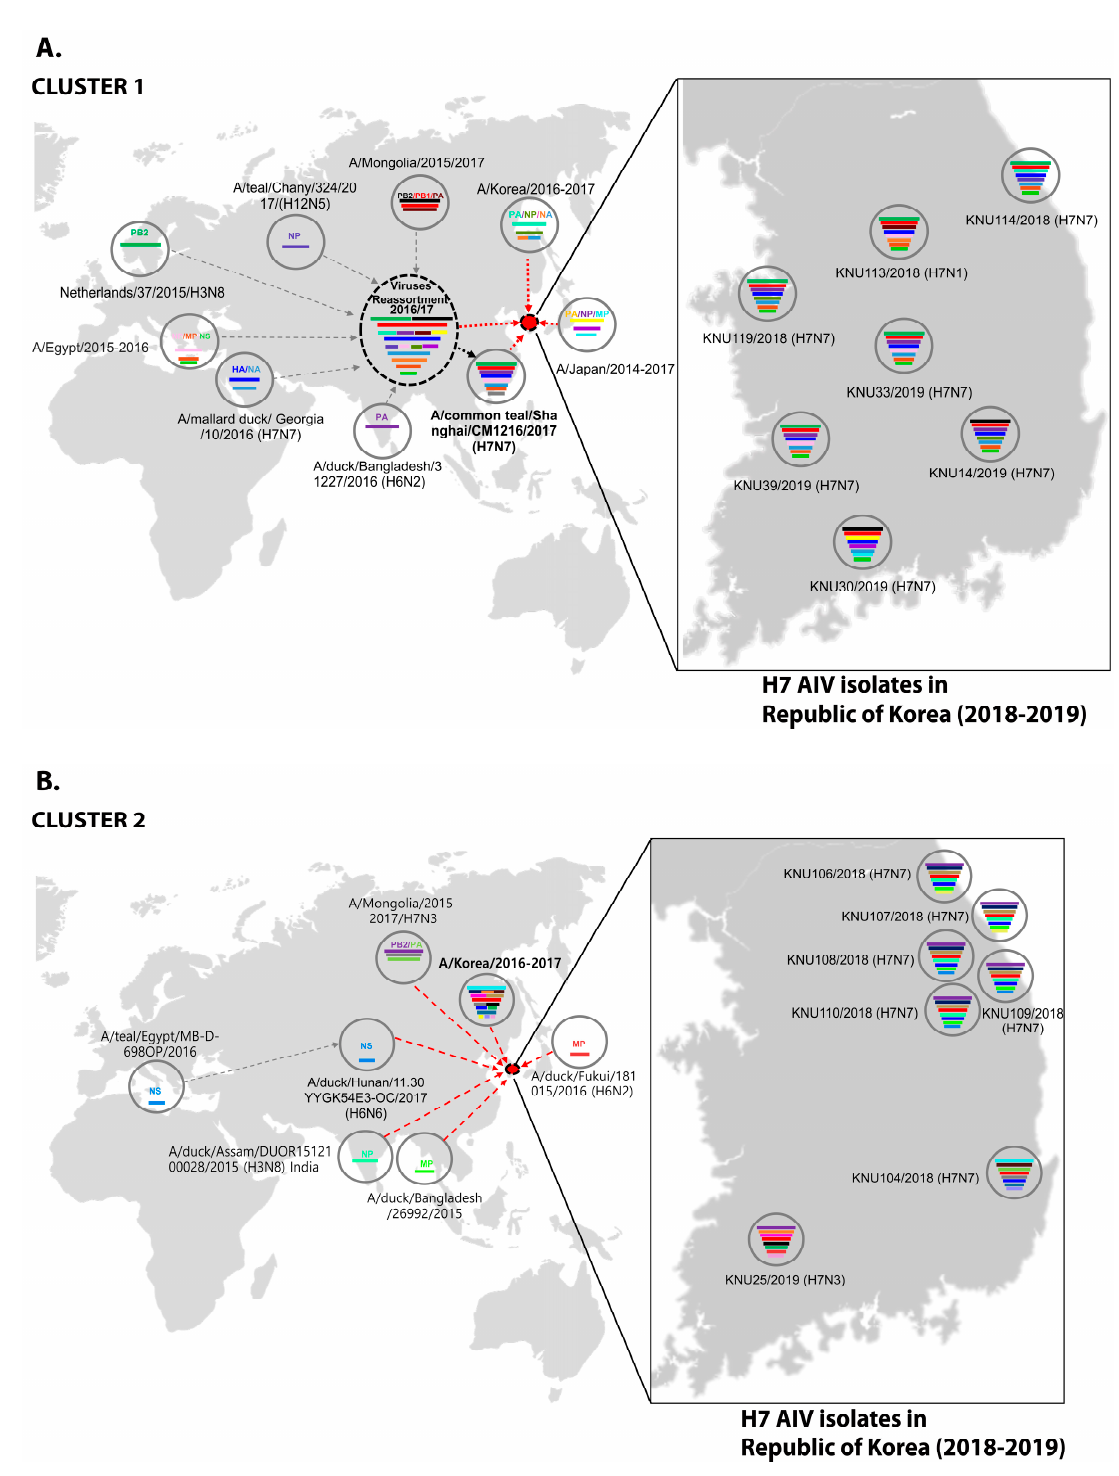
Figure 3. Figure 3. Original reassortment events of the novel avian influenza H7 isolates isolated during 2018–2019 in the Republic of Korea. ( A ) Cluster 1 represents possible reassortment events associated with KNU106/2018, KNU107/2018, KNU108/2018, KNU110/2018, KNU109/2018, KNU104/2018, and KNU25/2019. ( B ) Cluster 2 involves possible reassortment events associated with most of our isolates from 2019 and a few from 2018, such as KNU114, KNU113, and